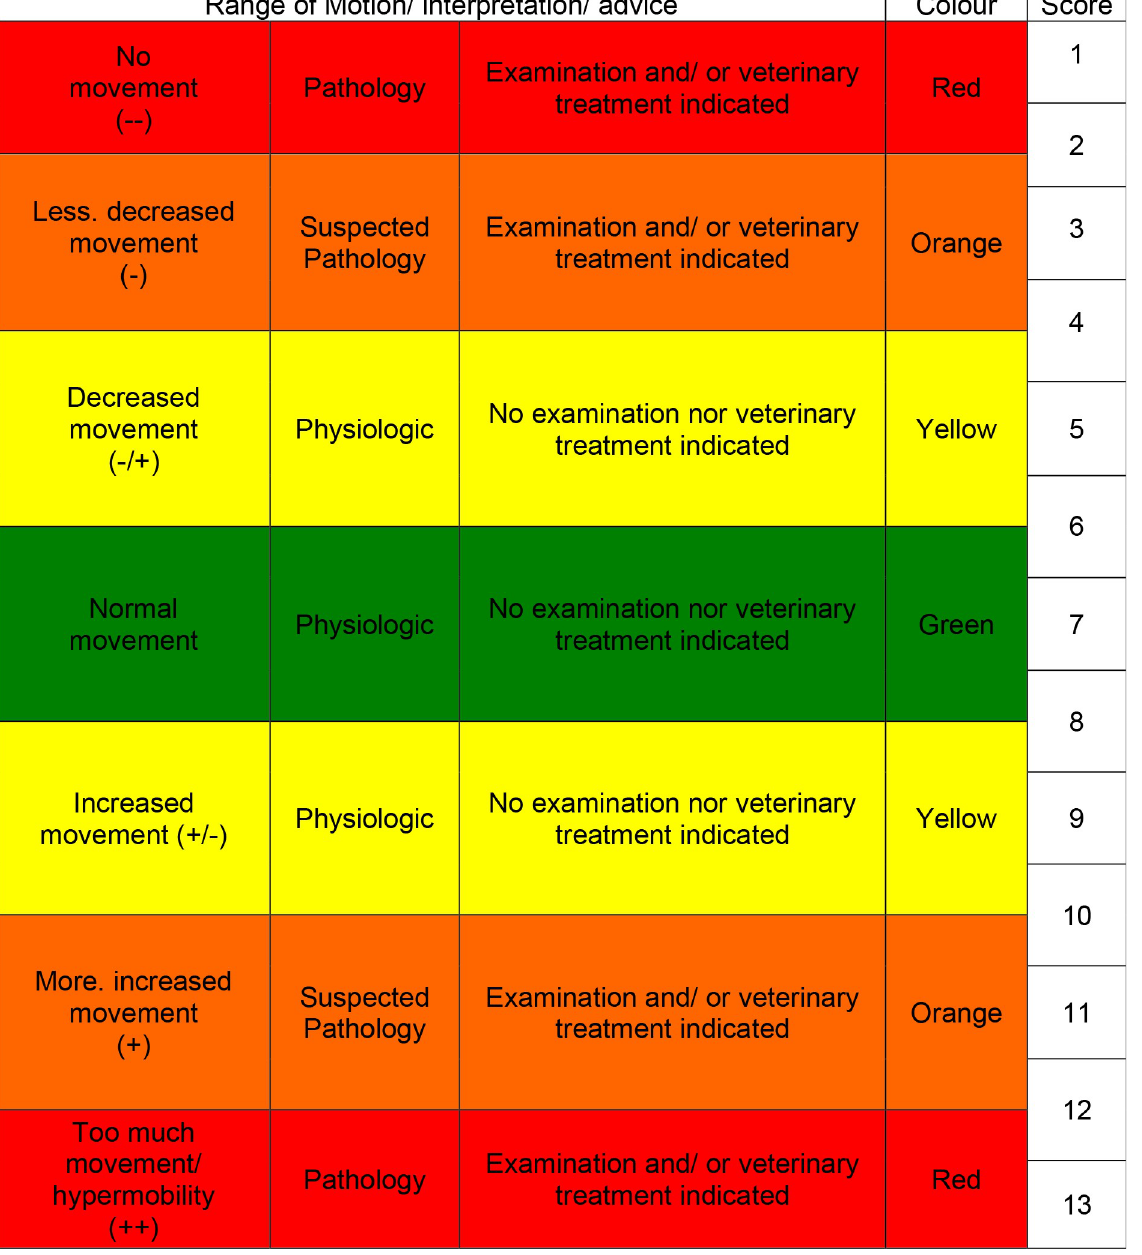
PLOS ONE | https://doi.org/10.1371/journal.pone.0252536 June 4,